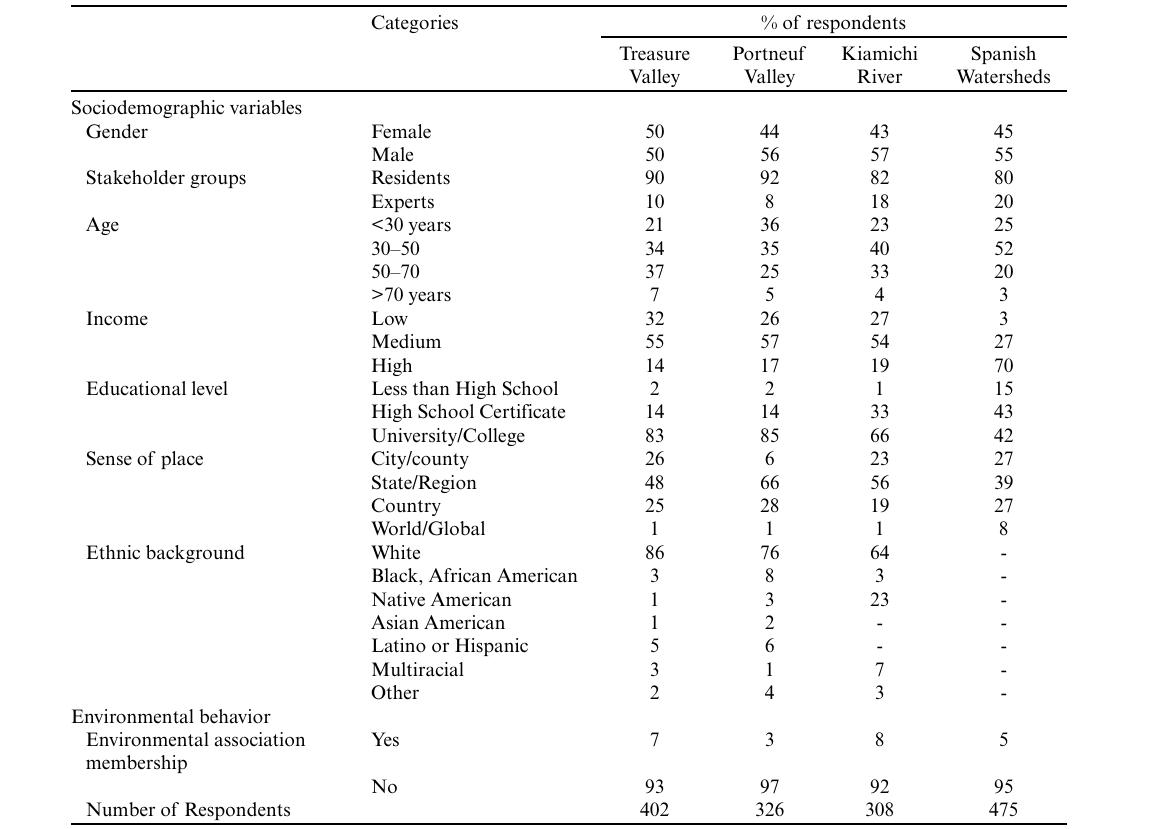
Table 2. Sociodemographic characterization of the four social samples.